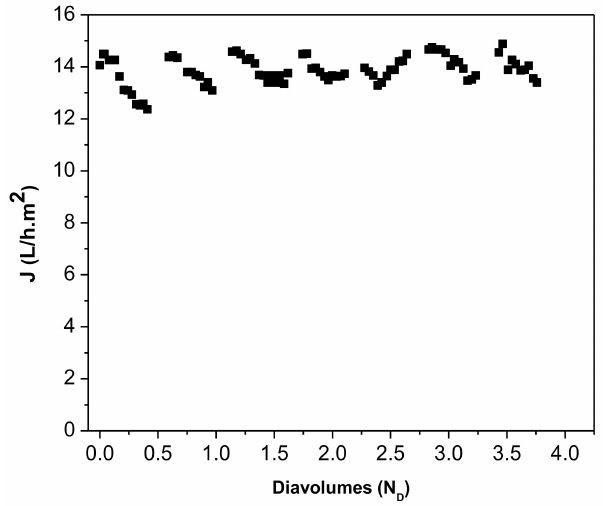
Figure 7. Permeate flux, J , obtained during the diafiltration of the SW30 concentrate of the real tannery effluent with the cs-PES MF022 membrane at an applied pressure of 20